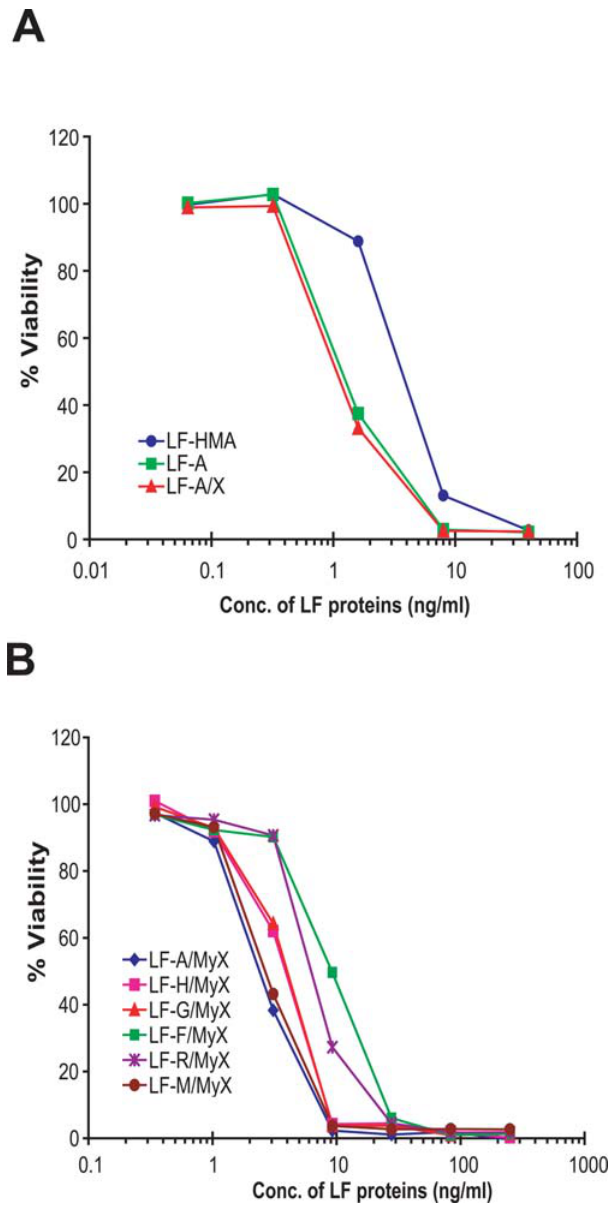
Figure 2. Cytotoxicity of LF proteins to RAW264.7 cells. RAW264.7 cells were incubated with various concentrations of LF- HMA, LF-A, and LF-A/X proteins (A) or LF proteins with mutated N- termini (B) and a fixed concentration of PA (250 ng/ml). Cell viability was assessed at 3 h. Percent viability was calculated relative to cells treated with medium (no